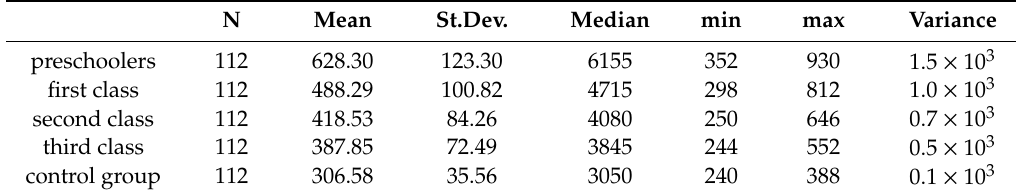
Table 1. Descriptive Statistics of reaction time (milliseconds).